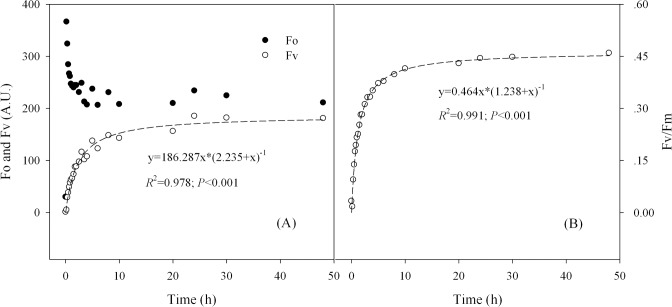
Fitting curves of the recovered Fo, Fv (A) and Fv/Fm (B) and their corresponding fitting equations in the rehydrated lichen soil crusts. Each fluorescence parameter just show the results of one sample from the three similar repetitions, and the other repetitive results are given in the Figure A in S1 File.